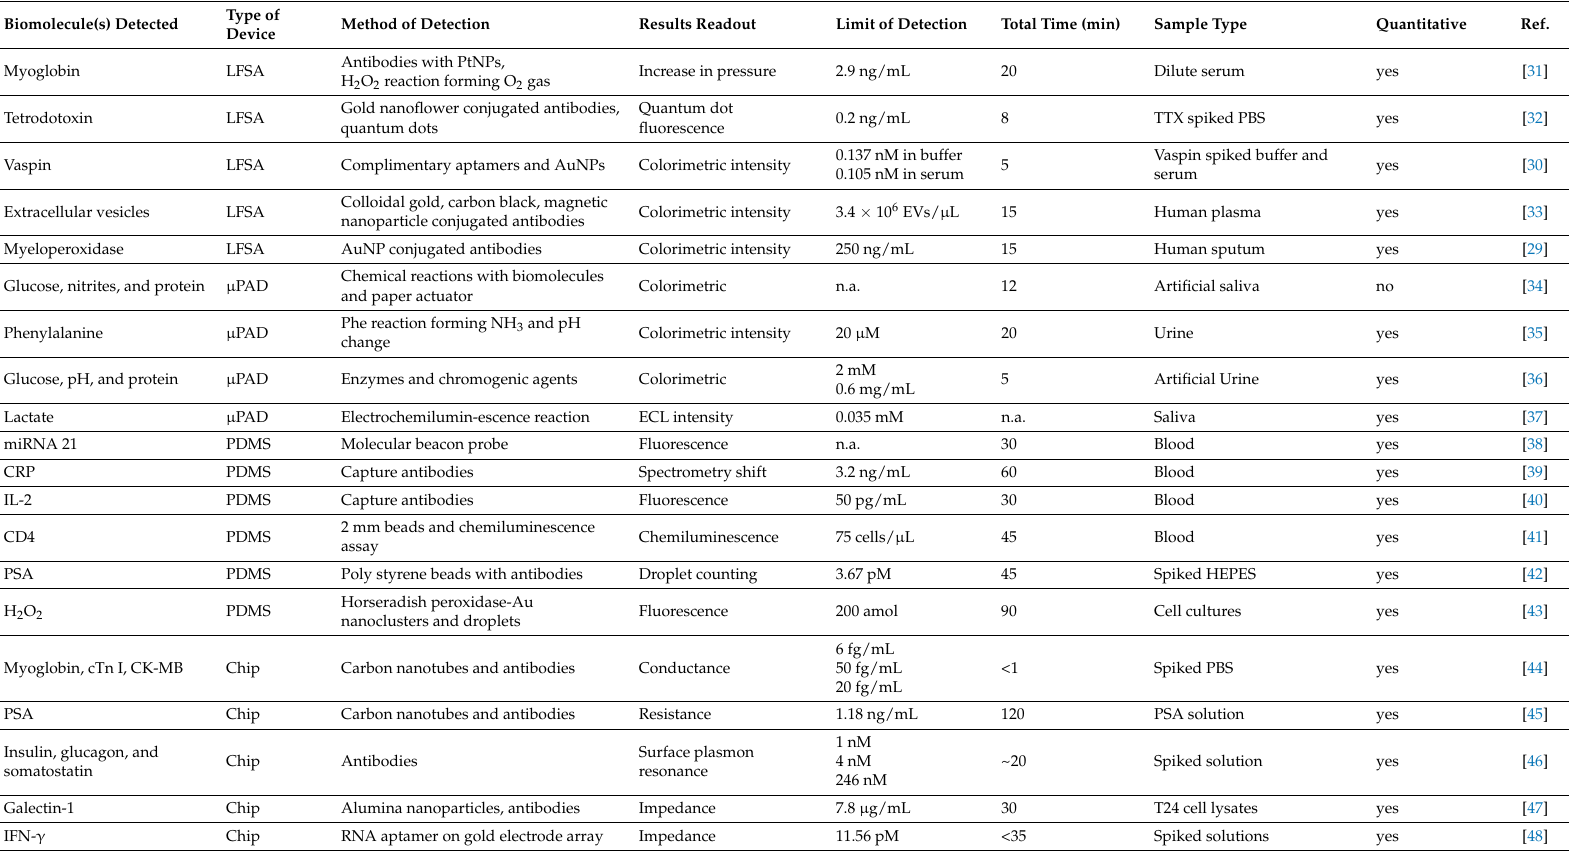
Table 1. Device methods and technical specifications for biomarker